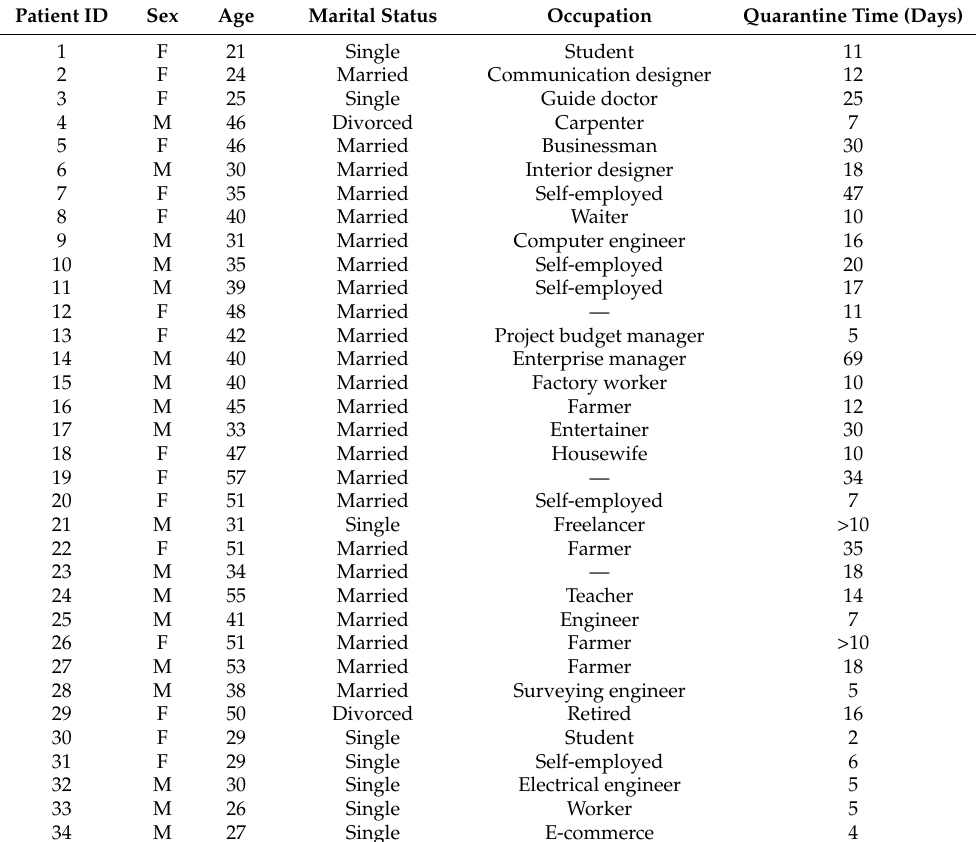
Table 1. Demographic information of the 34 COVID-19